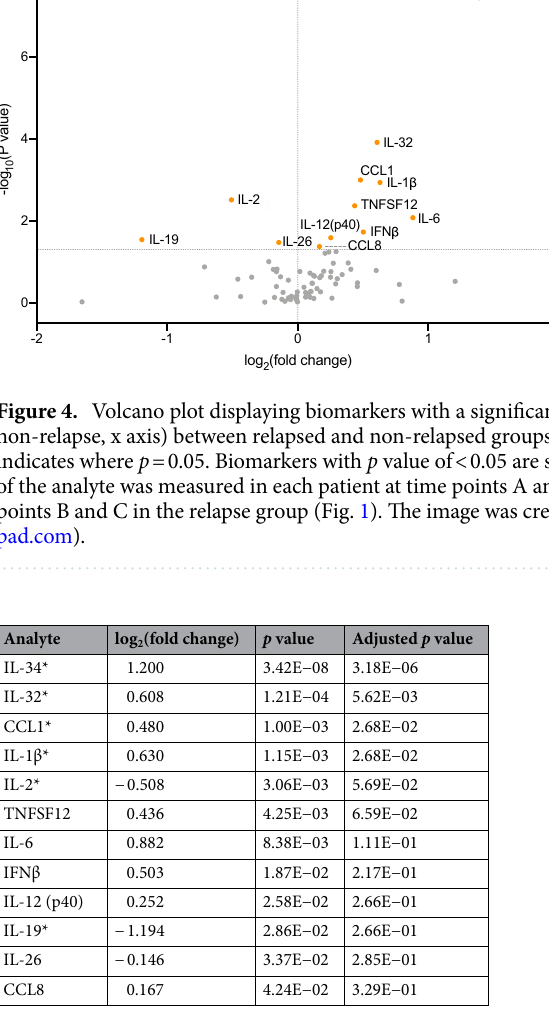
Table 2. Fold change of significant biomarkers. A positive fold change indicates a higher concentration in the relapse group. *High contribution features by the sPLS-DA. The serum concentration of the analyte was measured in each patient at time points A and F in the sustained remission group and at time points B and C in the relapse group (Fig. 1).